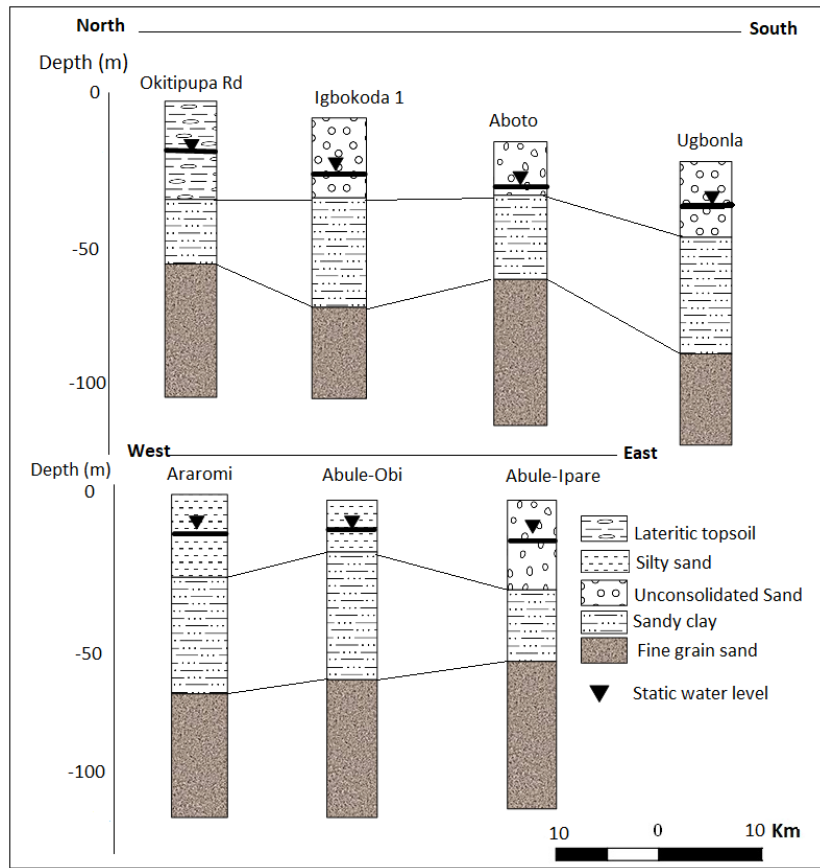
Figure 11. Lithological description of profiles A–B and C–D.